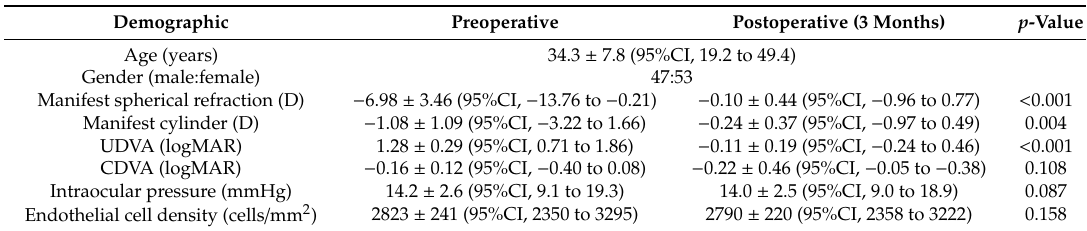
Table 1. Preoperative and postoperative demographics of the study population undergoing Implantable Collamer Lens (ICL)